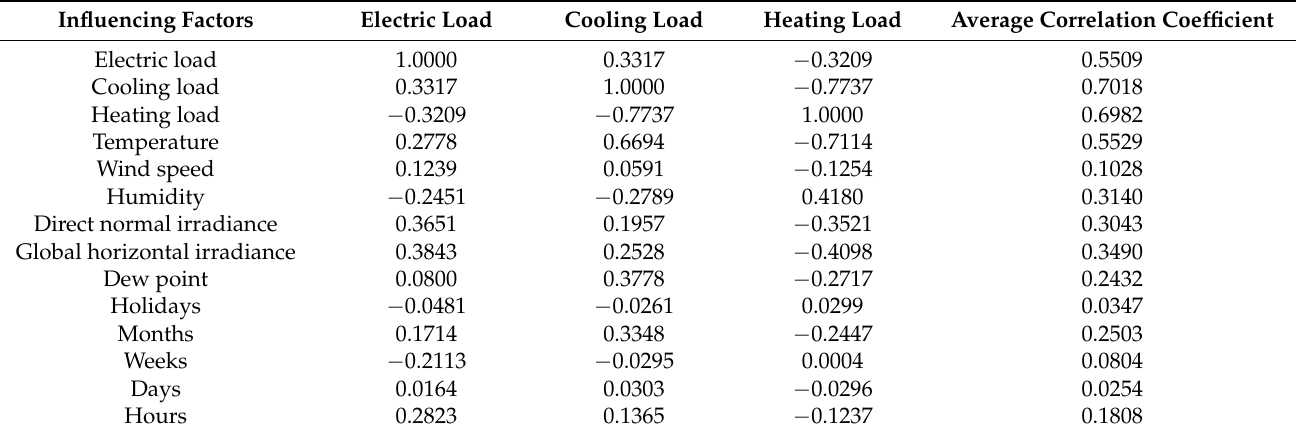
Table 1. The correlation value between each